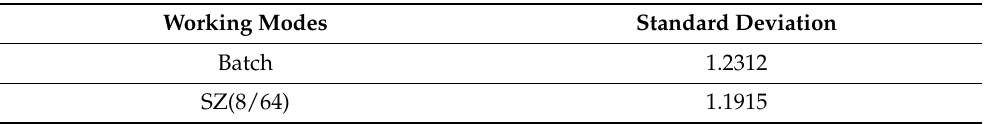
Table 5. The standard deviation of the effective area of algorithm and the corresponding area of the reference scene base